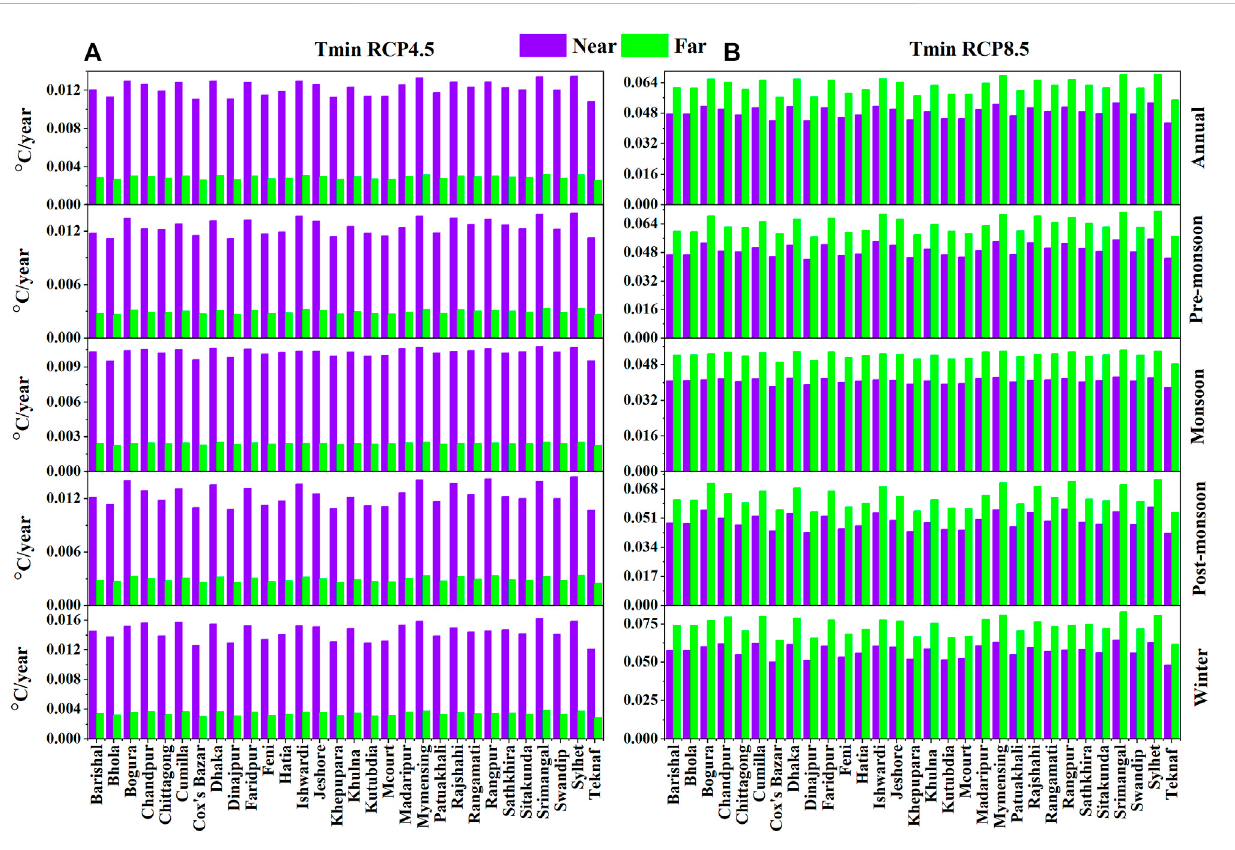
FIGURE 8 Sen ’ s slope estimator for annual and seasonal Tmin ( o C) trend (SS) analysis for near (2021 – 2060) and far (2061 – 2100) periods over Bangladesh at 30 meteorological stations under (A) RCP4.5 and (B)